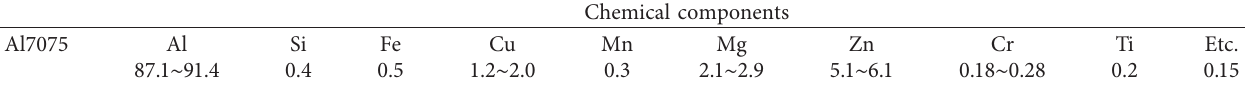
Table 1: Chemical compositions of Al7075-T6.